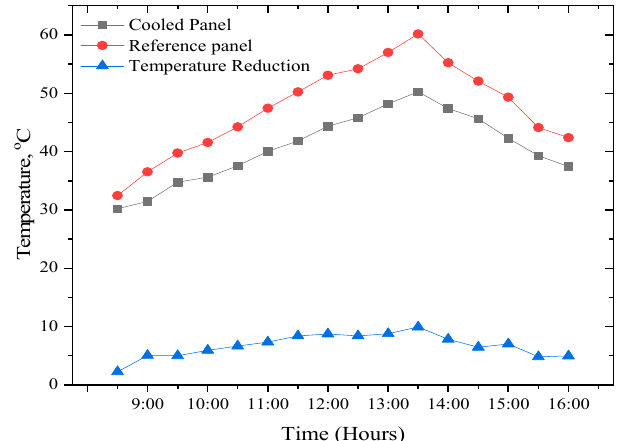
Figure 9. Time dependence of temperature of the two PV panels.